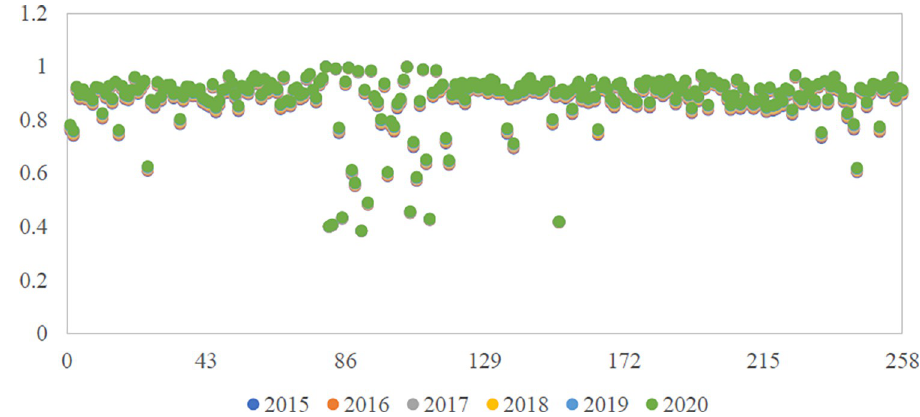
Fig 1. Distribution of capital allocation efficiency of enterprises from 2015 to 2020.